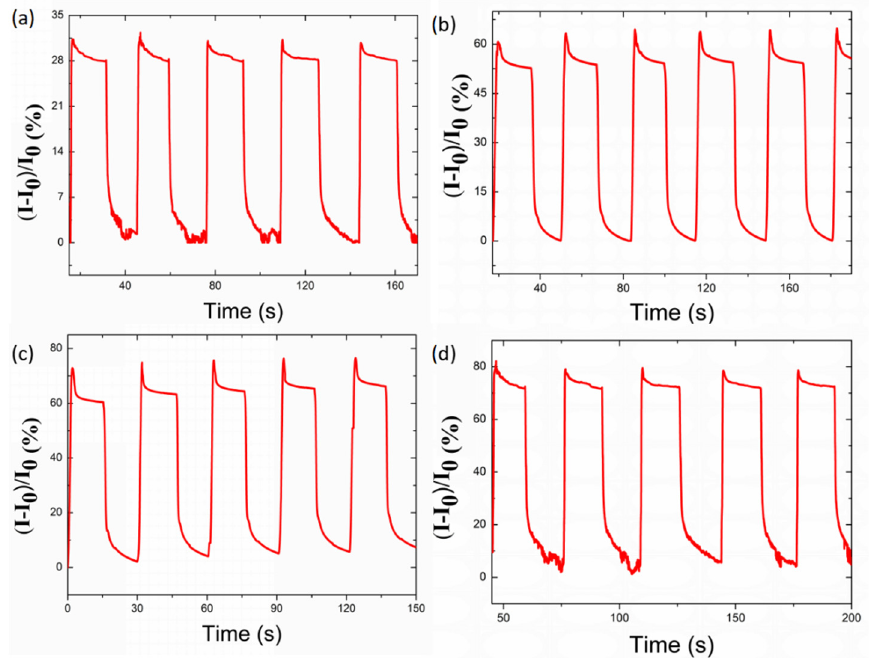
Figure 4. Current change of the TPU/graphene strain sensor with an intertwined-coil configuration subjected to ( a ) 100%, ( b ) 200%, ( c ) 300%, and ( d ) 400% tensile strain and then strain release in each cycle.